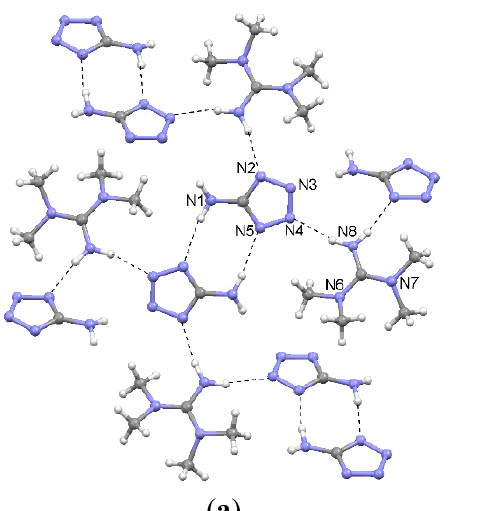
Figure 6. ( a ) Interactions in the crystal structure of 3 ; ( b ) Packing diagram of 3 ; hydrogen atoms are omitted for